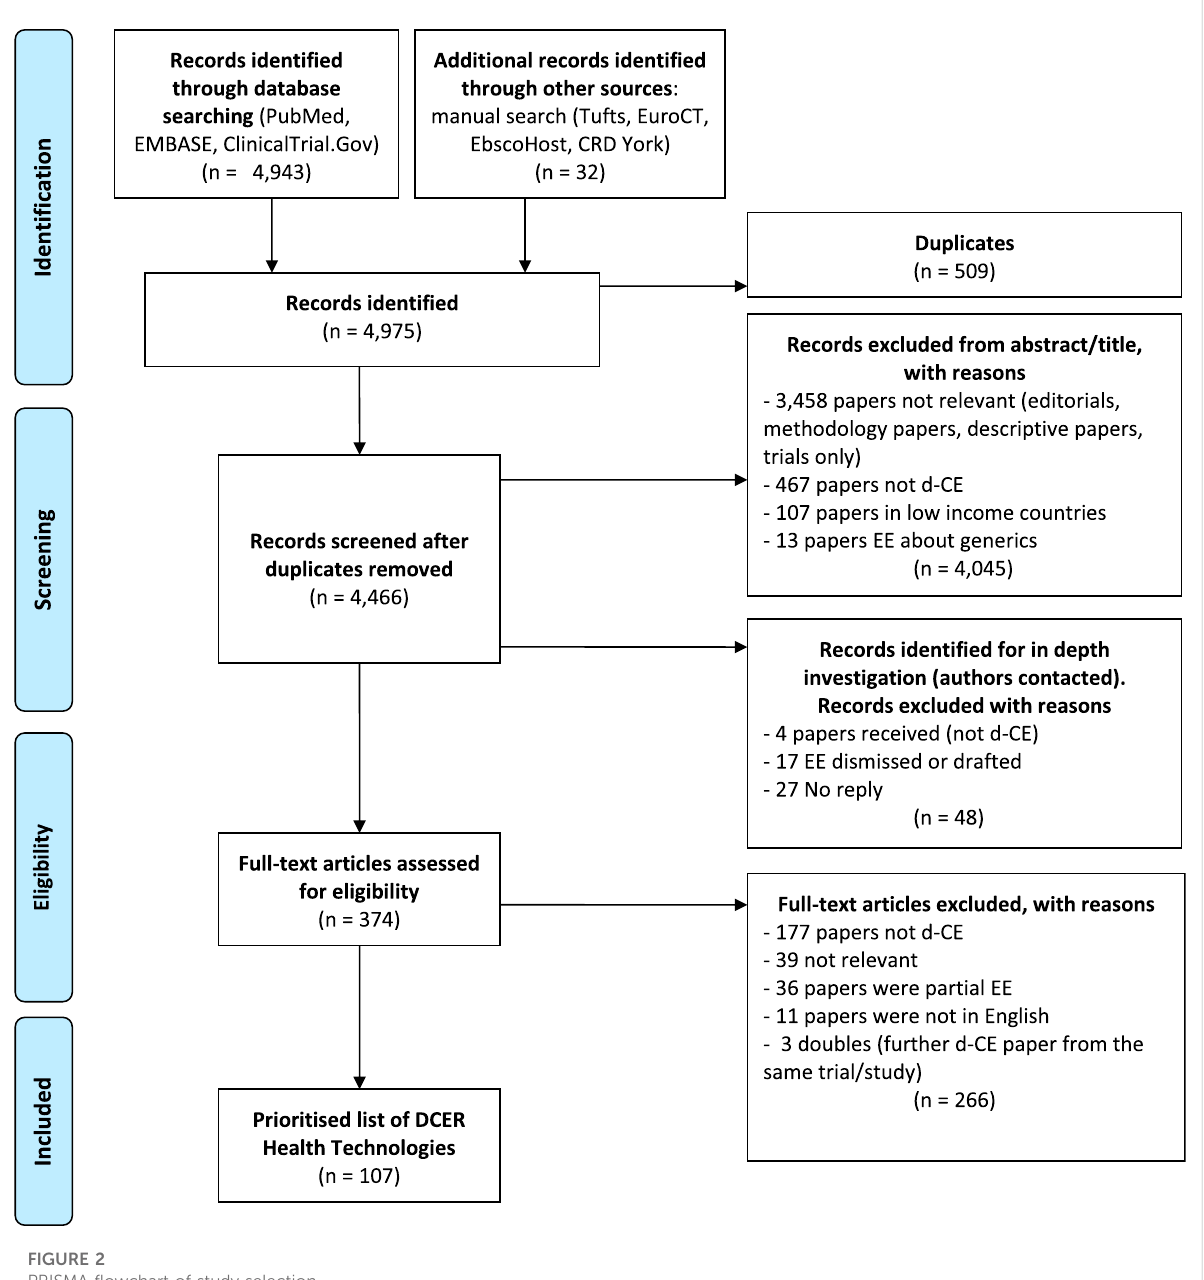
FIGURE 2 PRISMA fl owchart of study